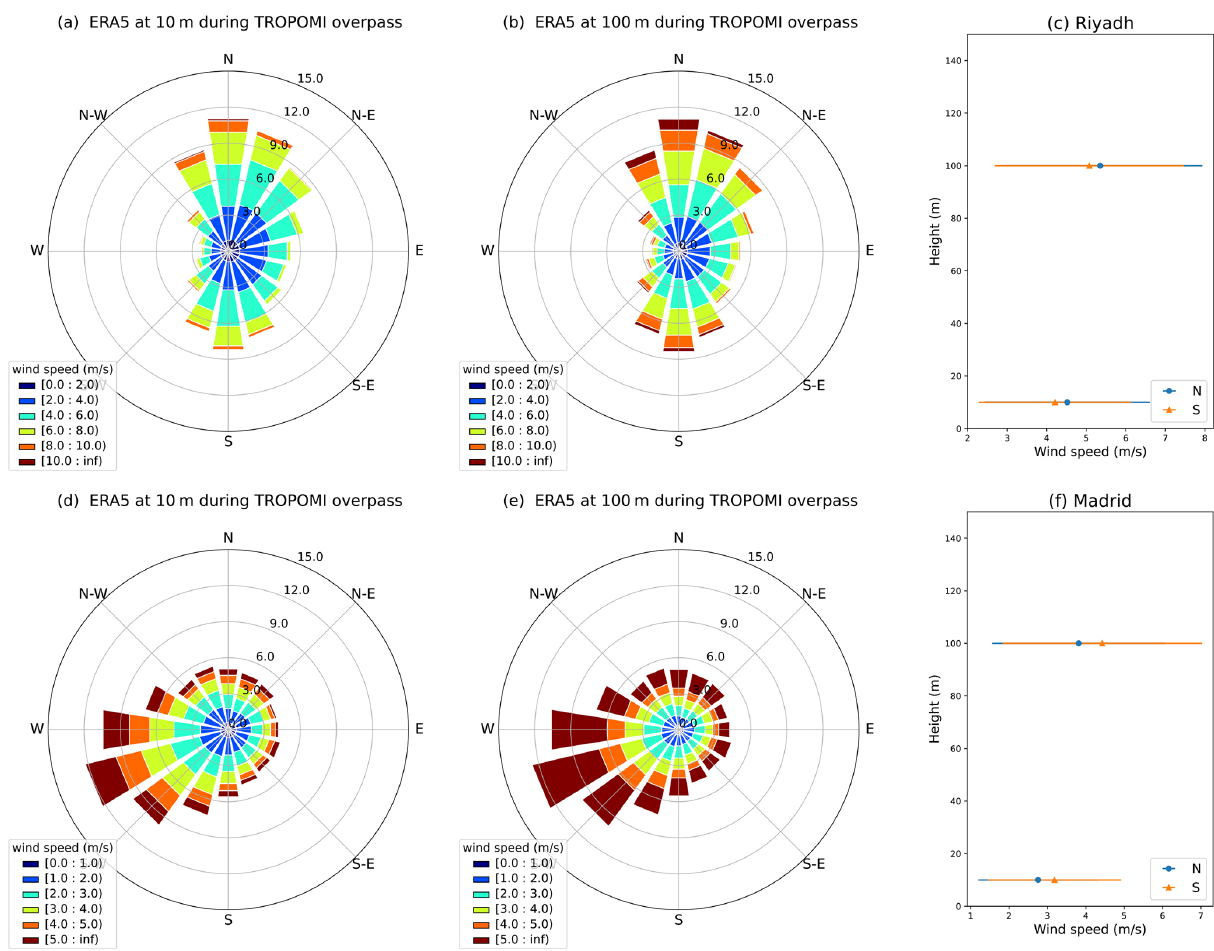
Figure A2. Wind roses of the daytime ERA5 model wind at 10 and 100m during TROPOMI overpasses and of wind speed at two levels in Riyadh (a–c) and Madrid (d–f) .